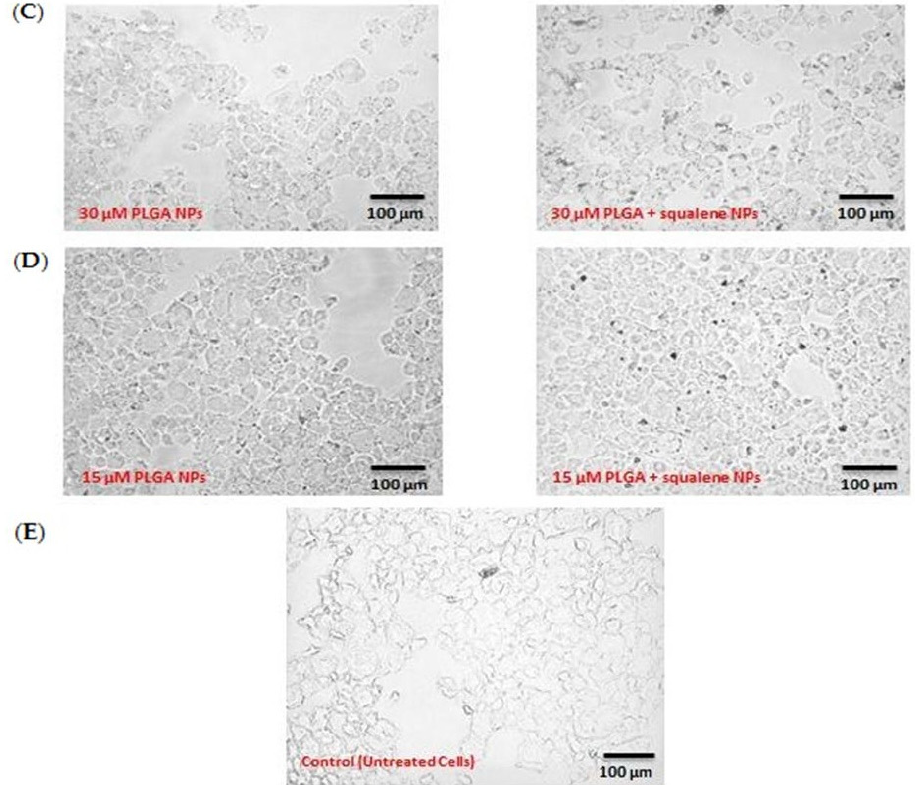
Figure 2. Detection of the effect of different PLGA nanoparticles concentrations (with and without squalene) on the AML12 cell line. ( A ) 150 µM, ( B ) 60 µM, ( C ) 30 µM, ( D ) 15 µM and ( E ) untreated cells.